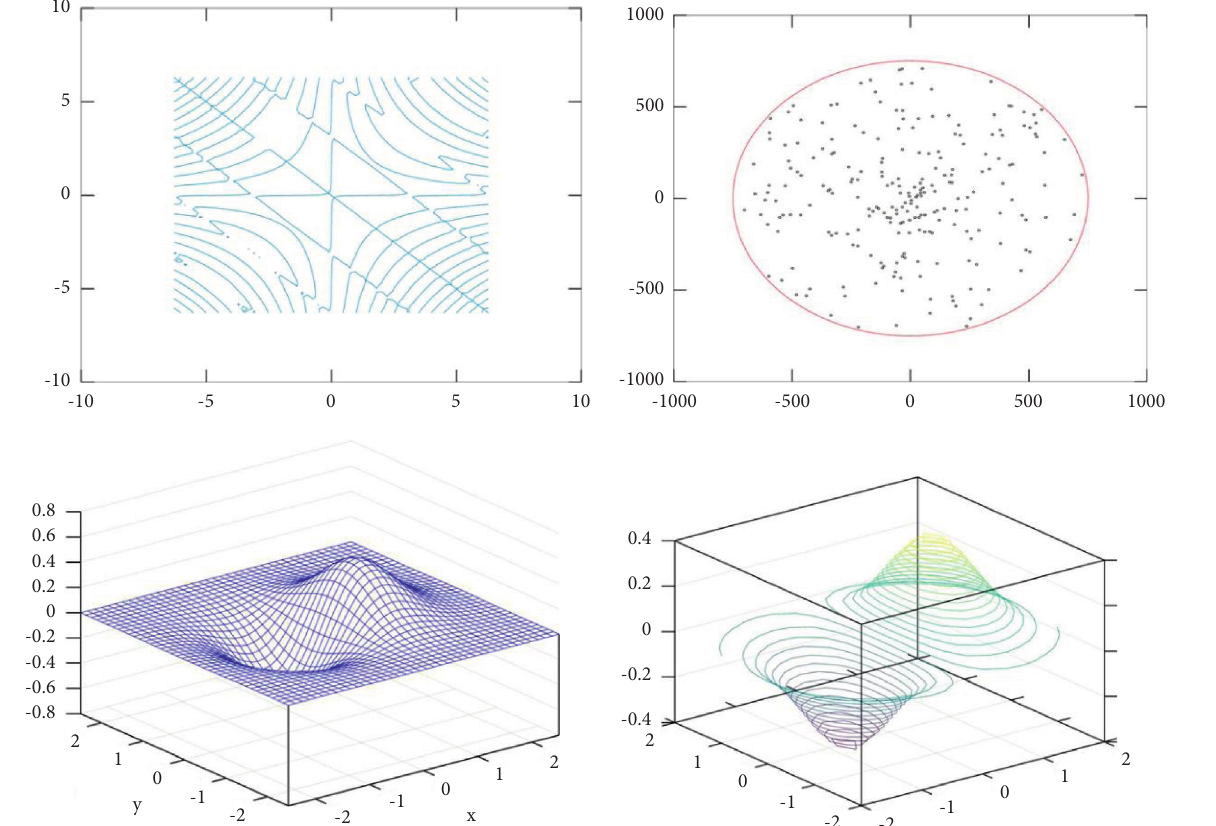
Figure 12: Comparison of the results of different test models selected in this